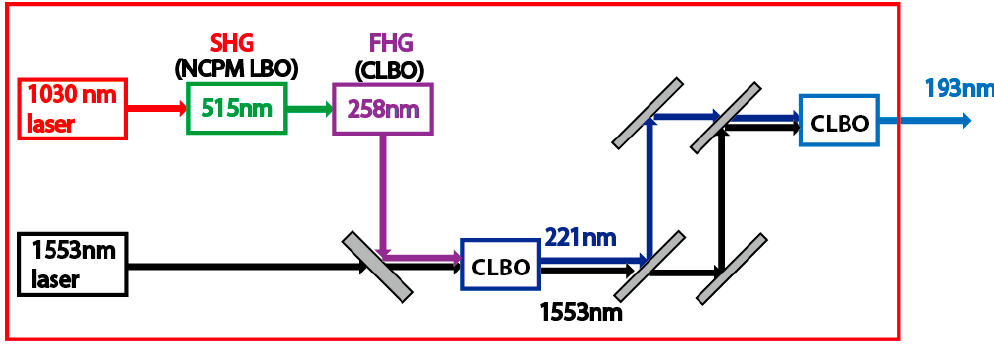
Figure 2. Schematic setup of 193 nm generation by frequency mixing of 1030-nm and 1553-nm lasers (NCPM: noncritical phase-matching).